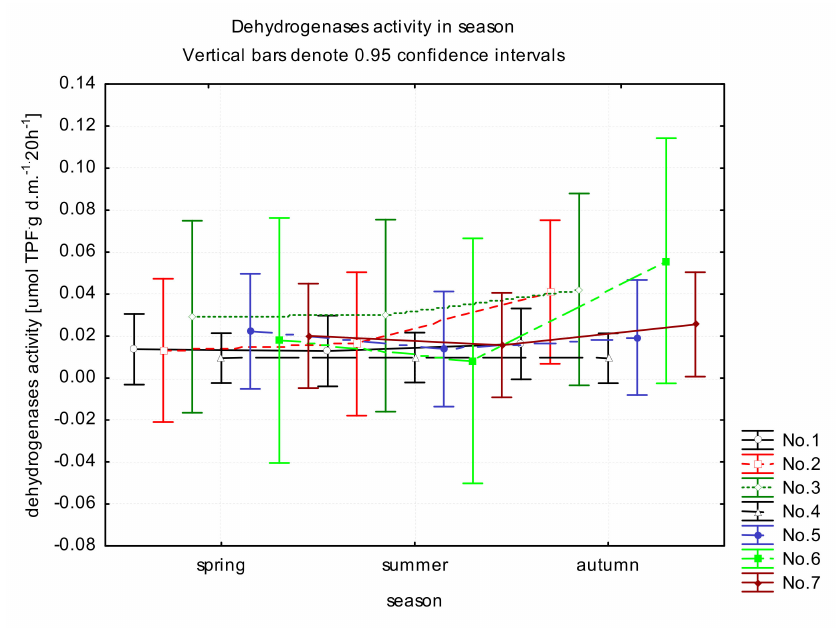
Figure 7. The average seasonal dehydrogenases